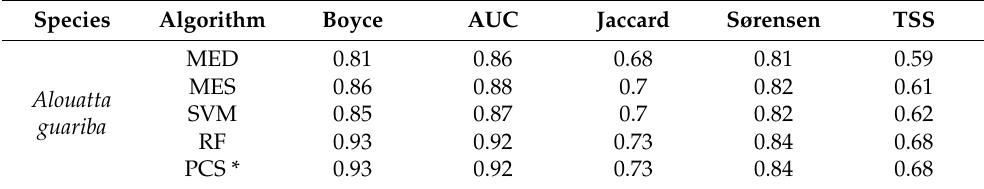
Figure A1. Map showing the known distribution ranges for the five primate species in the ecoregions identified in northern Argentina [19]. Table A1. The performance of four algorithms (MED = maximum entropy default, MES = maximum entropy simple, SVM = support vector machine, RF = random forest) and an ensemble model (PCS) were used to model the spatial distribution of the primate species of Argentina. Model performance metrics are in columns: Boyce’s index, the area under the curve (AUC), the similarity indices of Jaccard and Sørensen, and the true skill statistic (TSS).